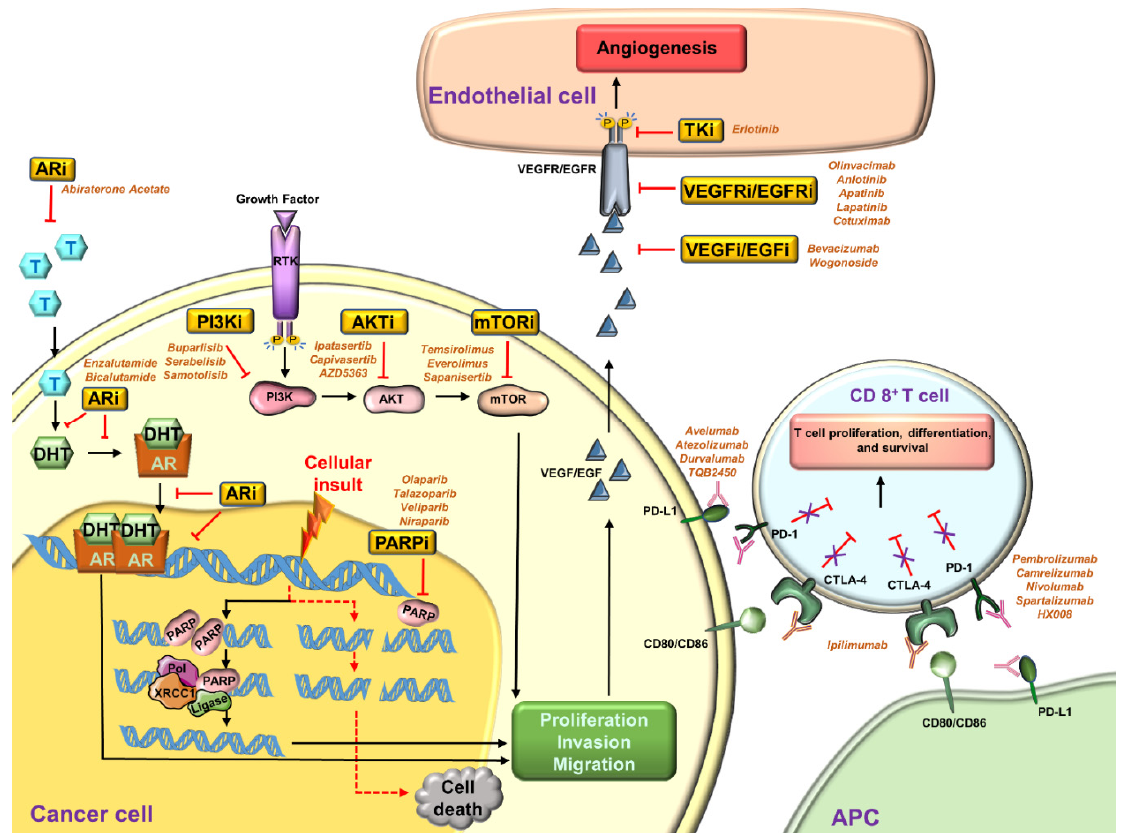
Figure 1. Therapeutic approaches to target specific pathways in TNBC . Inhibitors are mentioned in italics. (AR = andro- gen receptor; T = testosterone; DHT = dihydrotestosterone; PARP = poly (ADP-ribose) polymerase; XRCC1 = X-ray repair cross-complementing protein 1; Pol = polymerase); VEGF = vascular endothelial growth factor; VEGFR = VEGF receptor; EGF = epidermal growth factor; EGFR = epidermal growth factor receptor; TK = tyrosine kinase; PI3K = phosphoinositide 3-kinase; AKT = protein kinase B; mTOR = mammalian target of rapamycin; APC = antigen-presenting cell; CTLA-4 = cytotoxic T-lymphocyte-associated protein 4; CD80 = cluster of differentiation 80; CD86 = cluster of differentiation 86; PD-1 = programmed cell death protein 1; PD-L1 = programmed death-ligand 1).